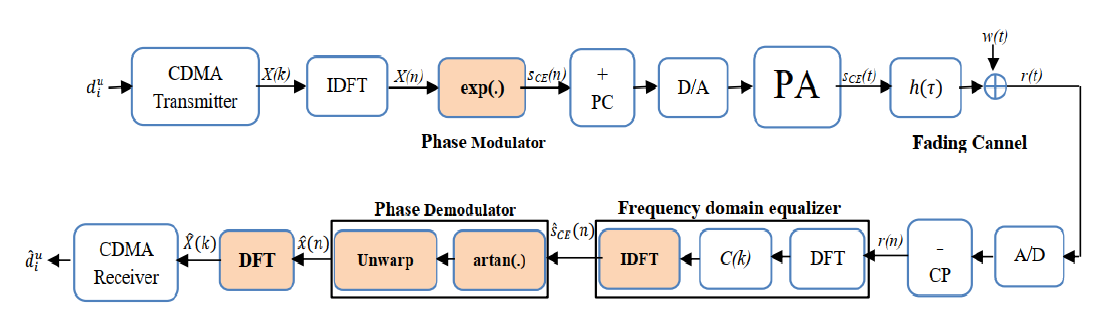
Figure 5. Baseband signal of a PM-OFDM-CDMA